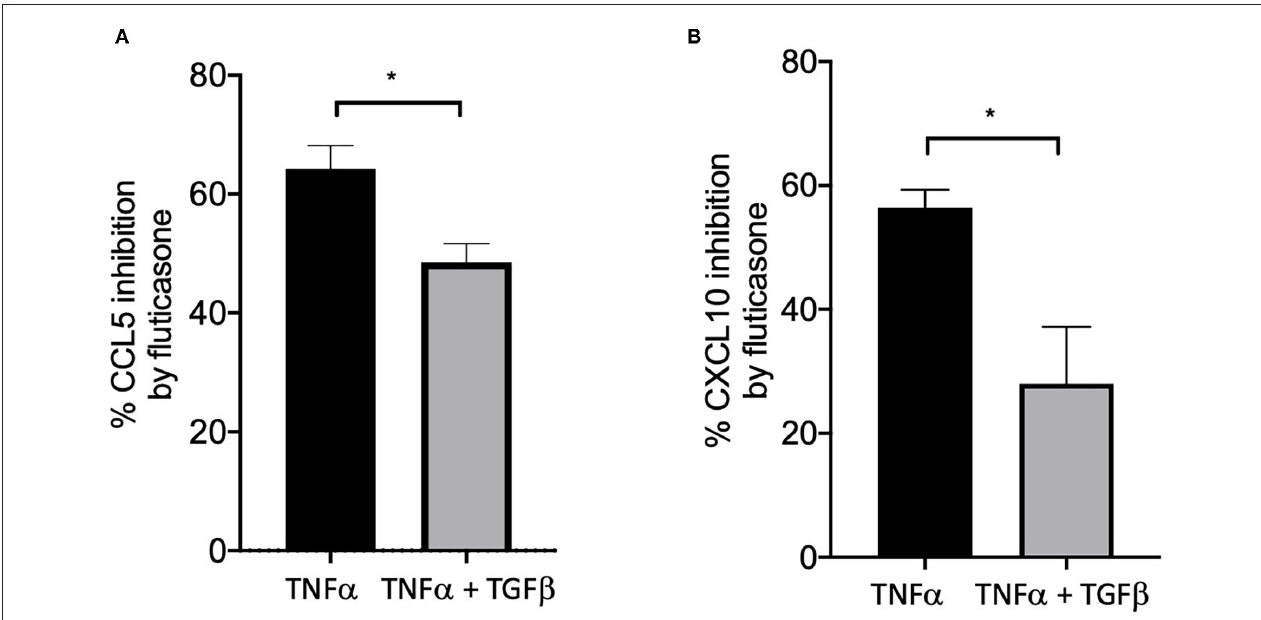
FIGURE 4 | TGF β impaired the capacity of fluticasone to inhibit TNF α -induced chemokine production. Healthy ASM cells were pre-treated with TGF β (10ng/ml) for 24h before being stimulated with 10ng/ml TNF- α with or without 100nM fluticasone for 24h. Chemokine expression of CCL5 (A) and CXCL10 (B) was assessed by ELISA with data presented as Means ± SEM of n = 3 different cell lines. Data are presented as % inhibition from chemokine responses in cells treated with TNF α alone or TNF α /TGF β (Means ± SEM of n = 5 different cell lines, * p < 0.05). Comparisons between groups were made using paired student t